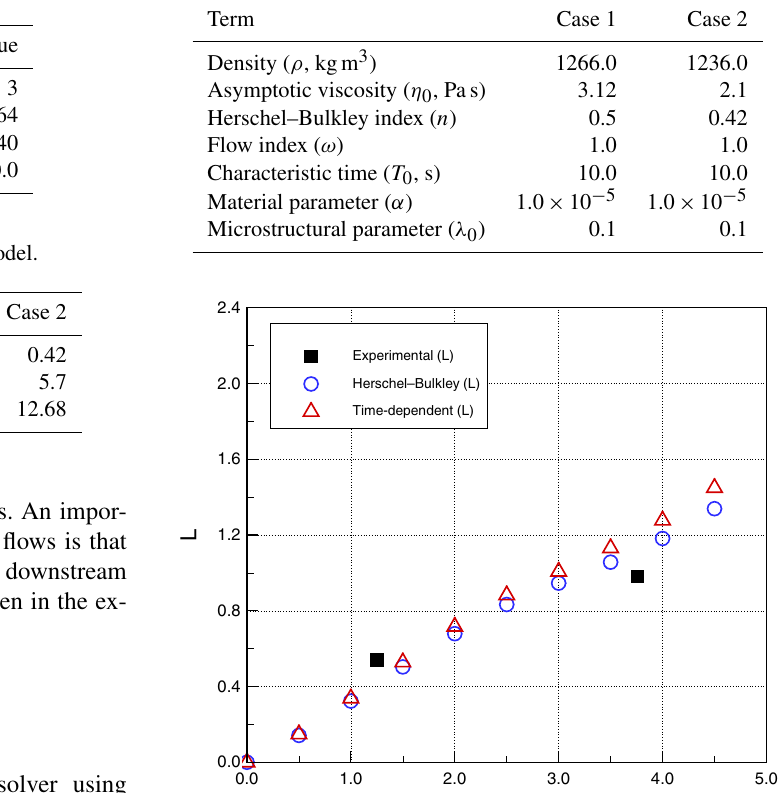
Table 4. Dimensions for simulations to match experiments by Haza et al. (2013).